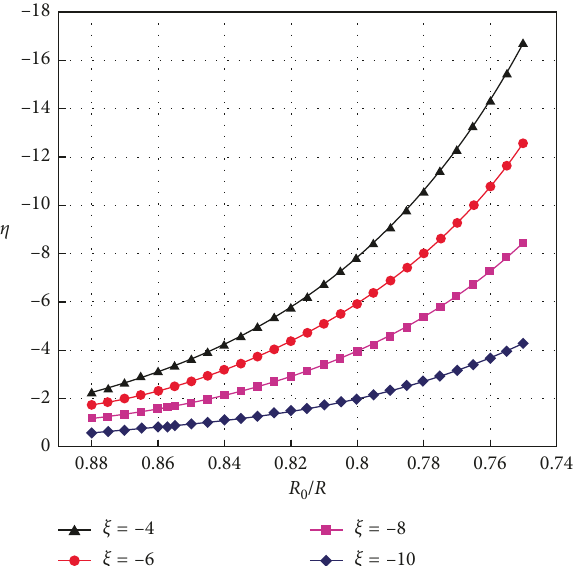
Figure 7: Relationship between plastic limit load q and b under /R con- 0 different σ z .